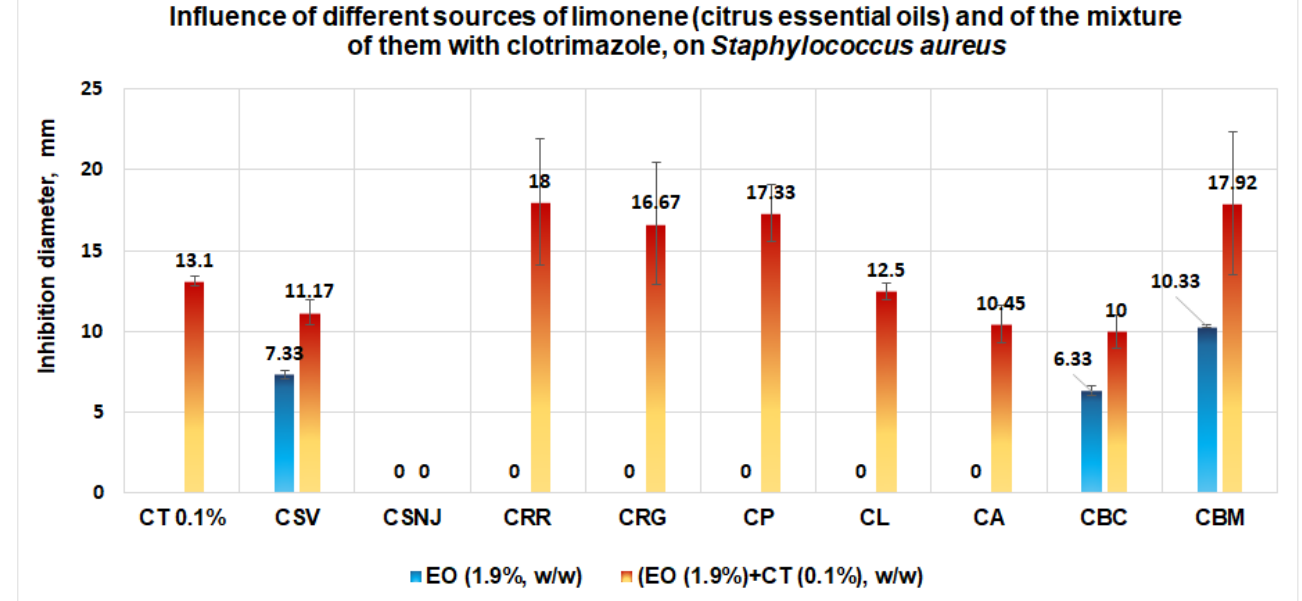
Figure 12. Influence of different sources of limonene (citrus essential oil, 1.9%, w/w) and of the mixture of them with clotrimazole (0.1%, w/w), on E.coli. No synergism between clotrimazole and the different sources of limonene was observed.